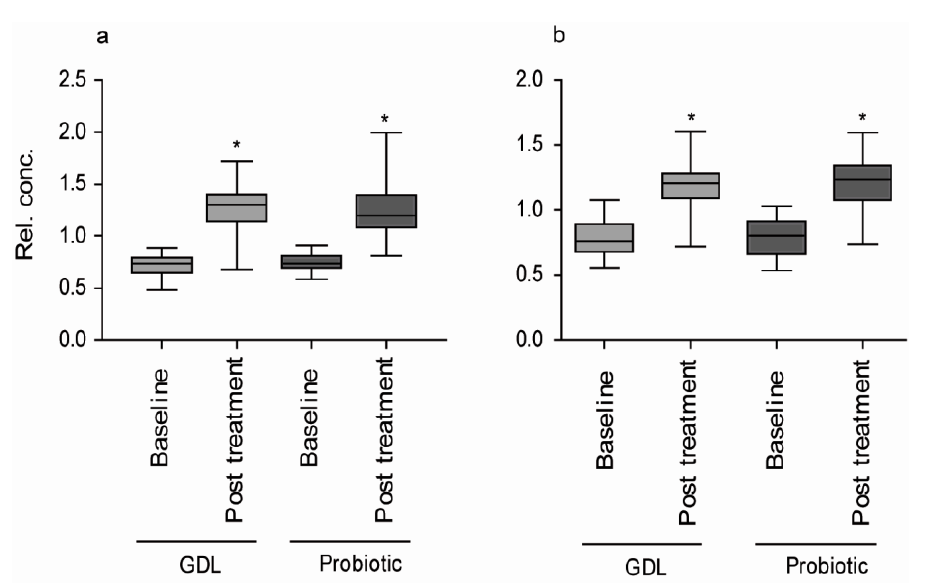
Figure 4. Relative concentration of lactate and 3-hydroxybutyrate based on signal intensity. ( a ) Lactate; ( b ) 3-hydroxybutyrate. Boxes represent 25th to 75th percentile of data and whiskers represent data spread. Asterisk (*) indicate that post treatment value is significantly different from baseline, P ≤ 0.05 .